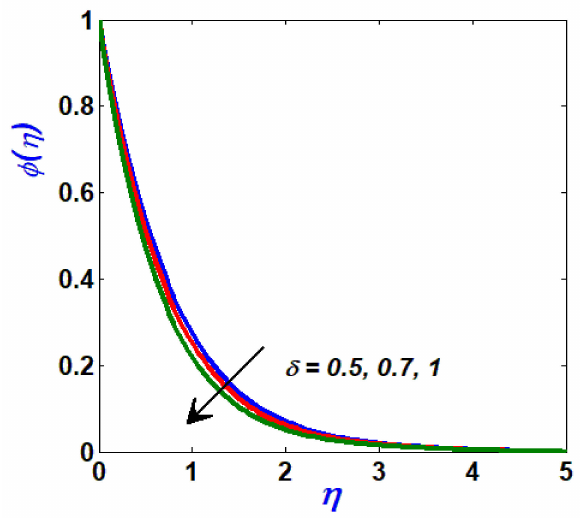
Figure 16. Concentration profile with variation in δ